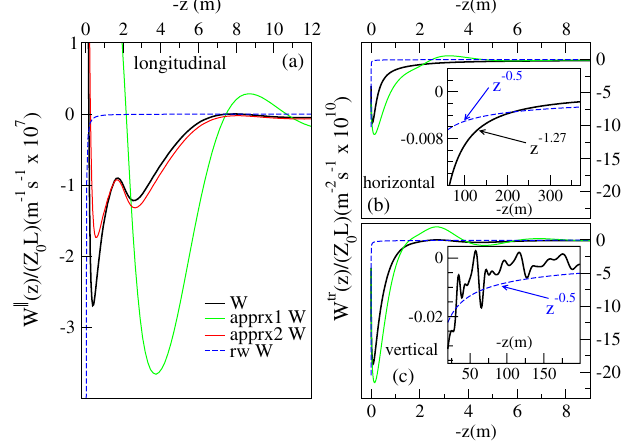
FIG. 5. Wake functions for a laminated chamber with parallel- plane geometry (black). The parameters are the same as in Fig. 4. (a) Longitudinal wake function versus distance j z j . The wake is repulsive up to j z j (cid:4) 0 : 2 m , then becomes attractive with a maximum around j z j (cid:4) 0 : 4 m . The longitudinal wake is much larger than the resistive-wall case for an iron chamber (blue). The approximations which neglect the (cid:5) dependence of R z (green) and the term proportional to R in the denominator of z Eq. (19) (red) yield significantly different results. (b) and (c) The horizontal (b) and vertical (c) wake functions. Compared to the resistive-wall wake (blue) they are much larger at distance of order of meters. However, they decay faster with increasing j z j . The horizontal wake becomes smaller than the resistive-wall wake at j z j > 200 m , while the vertical one becomes smaller at j z j > 30 m ; see the inset. Neglecting the (cid:5) dependence of R z (green) yields larger transverse